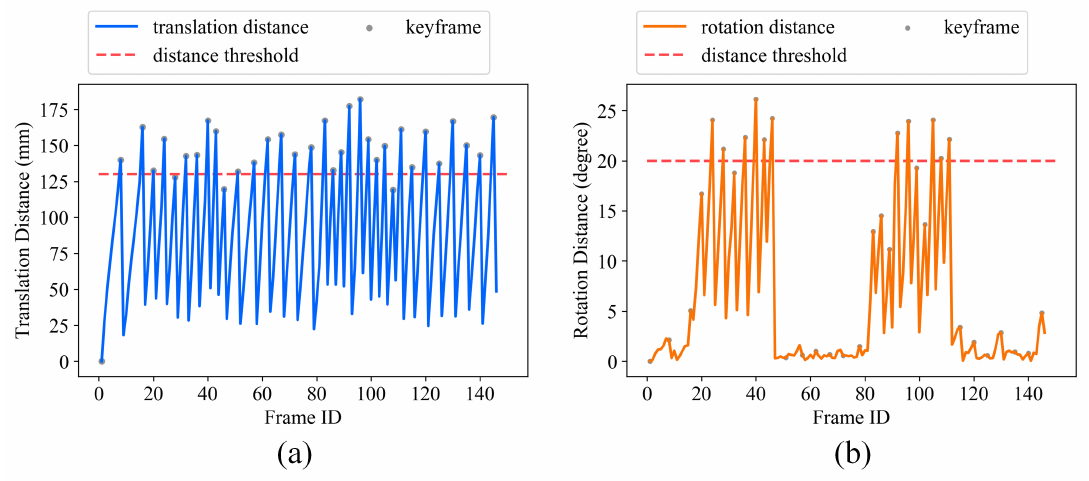
Figure 5. ( a , b ) show the translation and rotation distance between each frame with its previous keyframe,